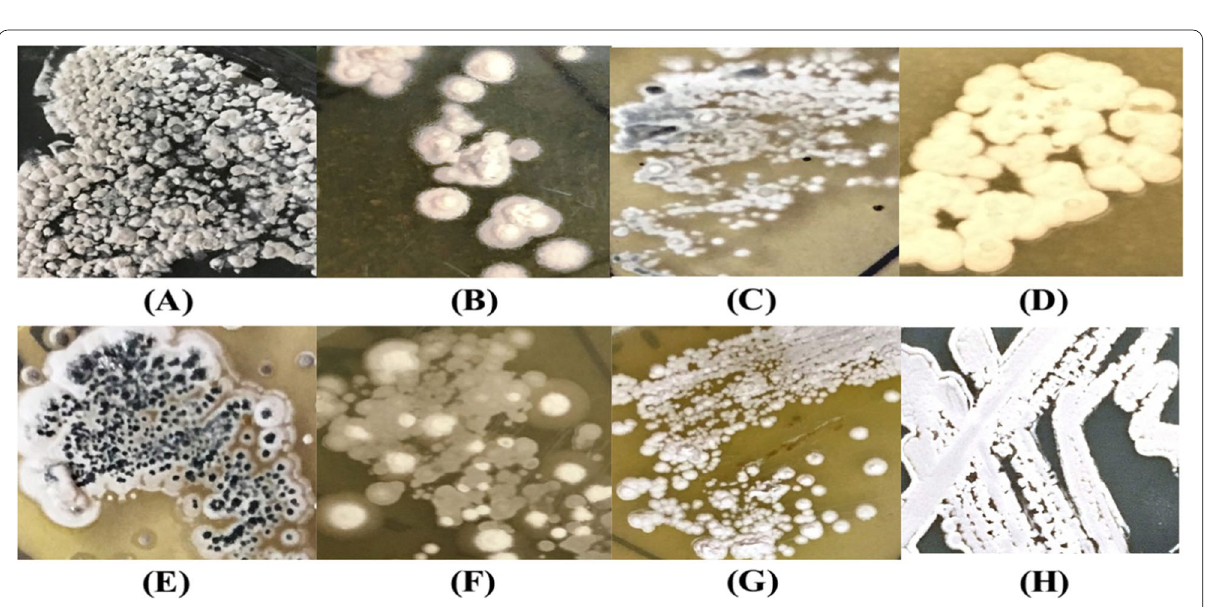
Fig. 3 Colonial appearance of the isolate JB140 on A modified actinomycetes specific (MAS) medium, B tryptone yeast extract agar (ISP1), C yeast extract maltose agar (ISP2), D oatmeal agar (ISP3), E inorganic salt starch agar (ISP4), F glycerol asparagine agar (ISP5), G peptone yeast extract iron agar (ISP6), H tyrosine agar